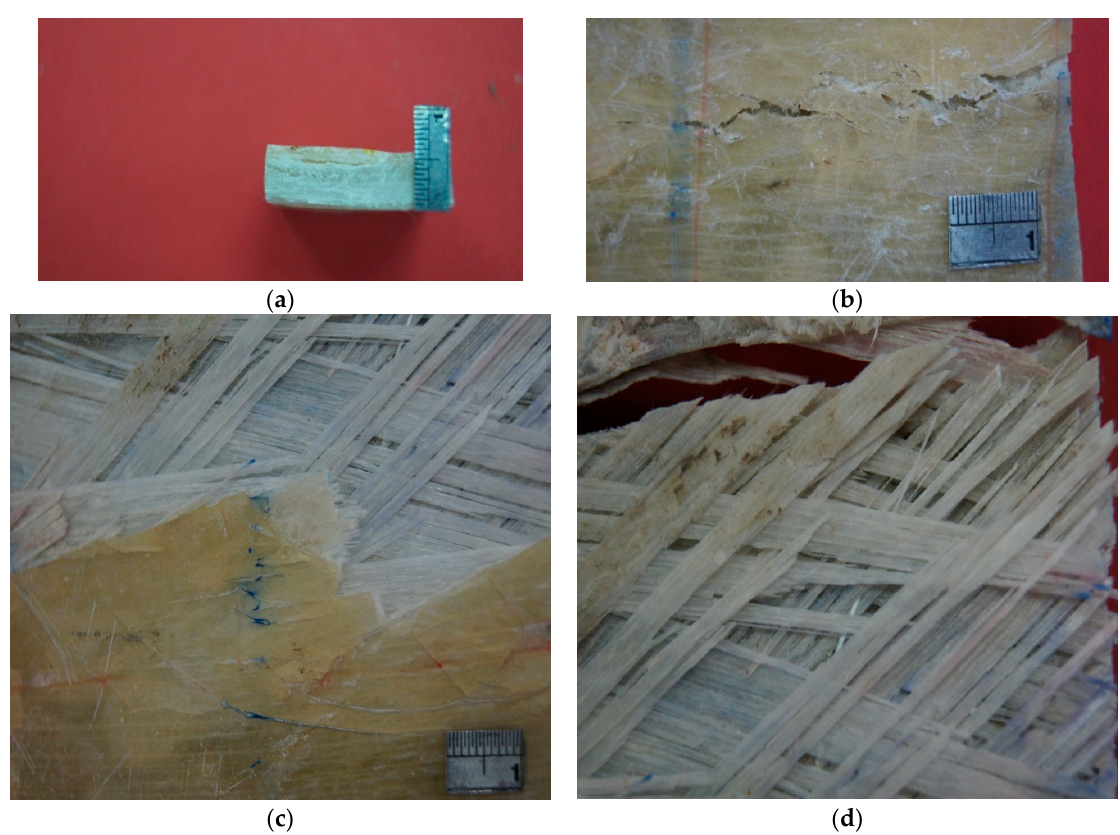
Figure 3. Fractured surface of (a) Interlaminar cracks throughout the elbow wall; (b)Interlaminar cracks at different magnifications; (c)Circumferential crack was observed to be initiated by matrix cracking; (d) Close up of crack revealing, matrix cracking, poor fiber–matrix interface, fiber debonding, and delamination at tip crack.